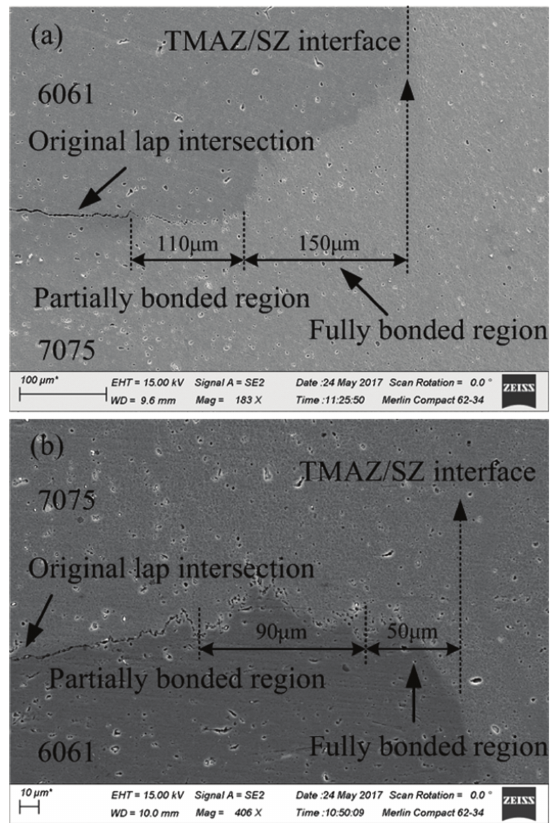
Figure 3: Microstructure of hook region using (a) 6061 and (b) 7075 as the upper